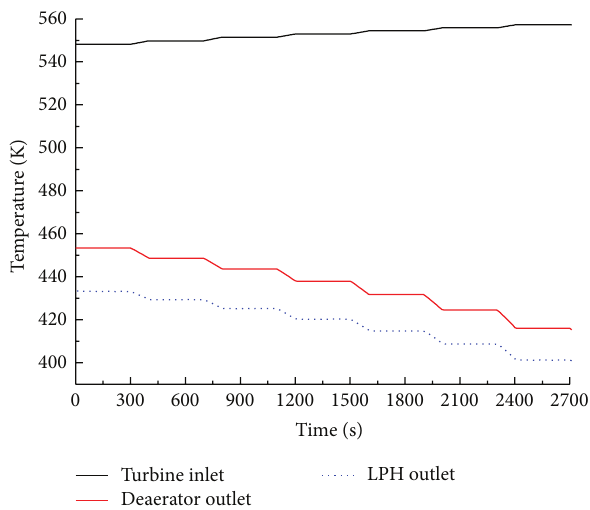
Figure 5: Transient change of temperature for turbine inlet, LPH outlet, and deaerator outlet.